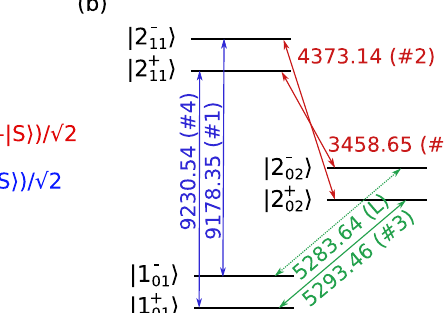
where J isthetotalangularmomentum, K a and K c aretheprojectionsoftheangular momentum onto the molecular axes a and c, and ± indicates the parity of the torsional state. M sublevels of the rotational states are omitted here for clarity 29 . The arrows indicate the transitions involved. Each transition is labeled with its frequency(inMHz)anditsorderinthesequenceofthepulses(inparentheses). “ L ” indicates the “ listen ” transition, which is not directly excited by the pulse scheme but coherently , a K c